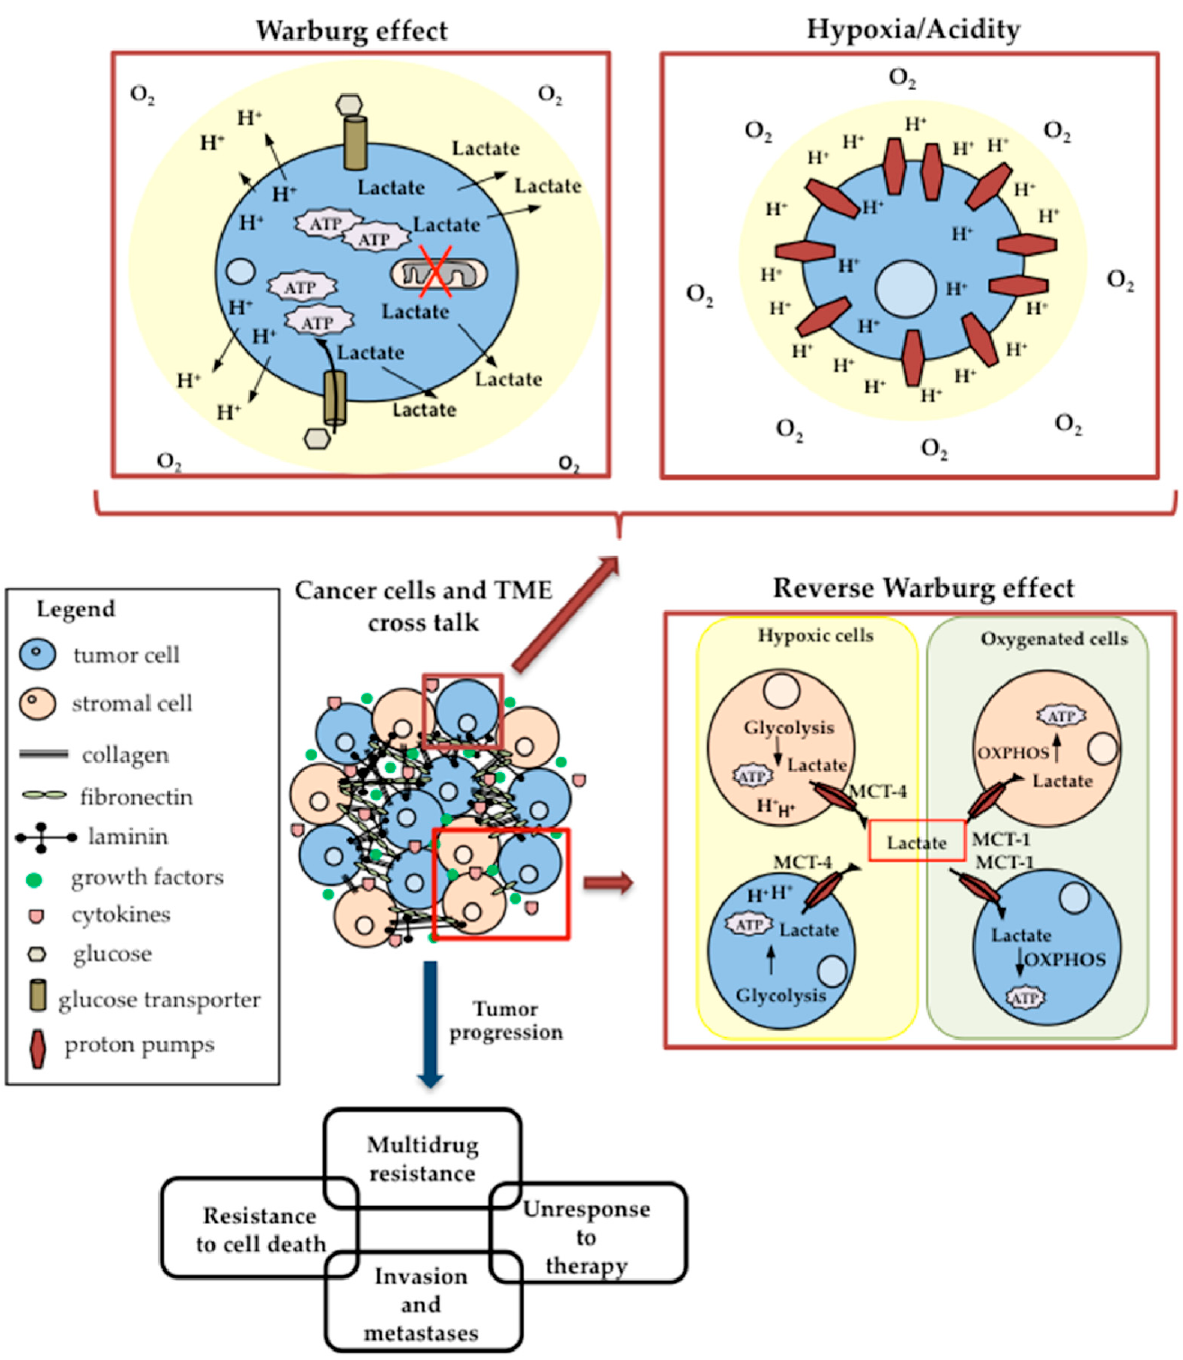
Figure 4. Cross talk between tumor cells and tumor microenvironment (TME). Normal cells, extracellular matrix proteins, growth factors, cytokines, metabolites, etc., characterize the TME. The interplay between tumor cells and their surrounding complex microenvironment can determine metabolic adaptation of cancer cells and tumor progression. Typical metabolic features of cancer cells are represented in boxes: Warburg effect, hypoxia, and acidity; reverse Warburg effect. Adapted from [82]. Legend: TME, tumor microenvironment; MCT-1, monocarboxylate transporter-1, MCT-4, monocarboxylate transporter-4; ATP, adenosine triphosphate; OXPHOS, oxidative phosphorylation. Due to their ability to directly activate transcription of target genes, an increased expression of HIF-1 α and HIF-2 α was reported in a variety of human cancers and was correlated with a switch versus a more aggressive phenotype [89]. Generally, both HIF-1 α and HIF-2 α show a positive correlation with tumor progression, but with some